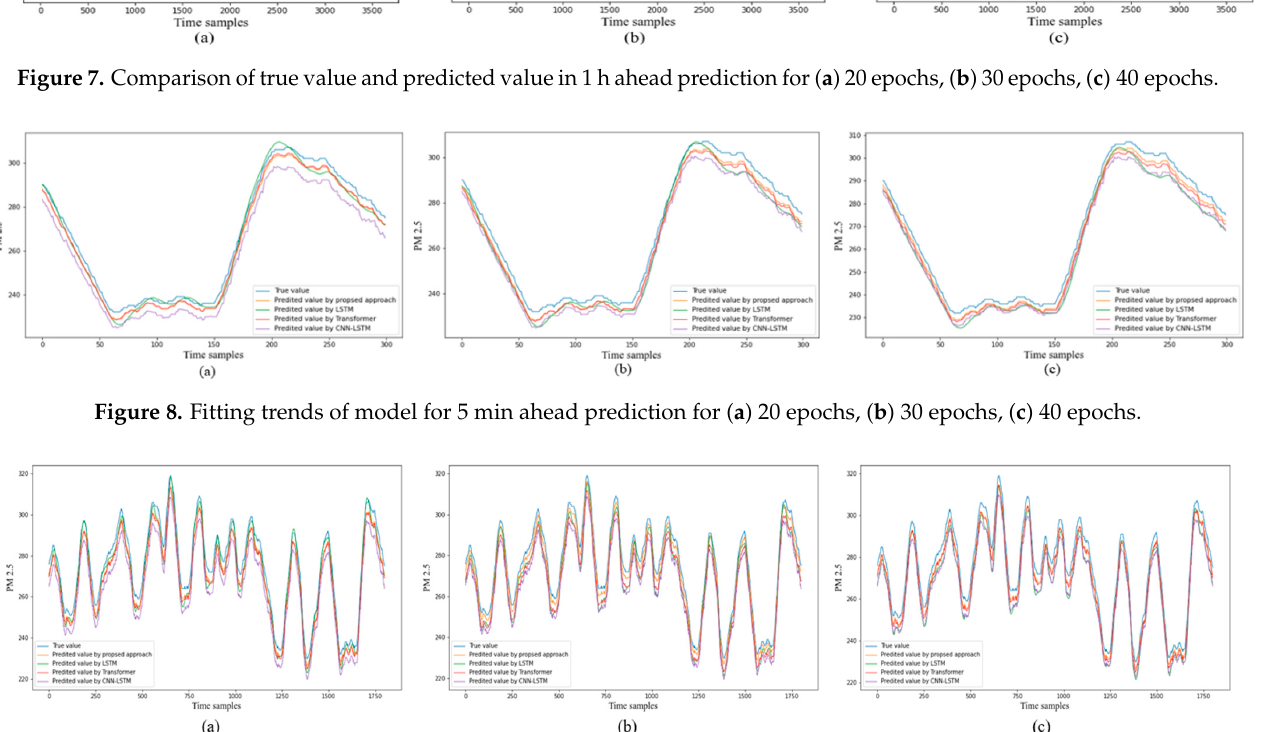
Figure 9. Fitting trends of model for 30 min ahead prediction. ( a ) 20 epochs. ( b ) 30 epochs. ( c ) 40 epochs.